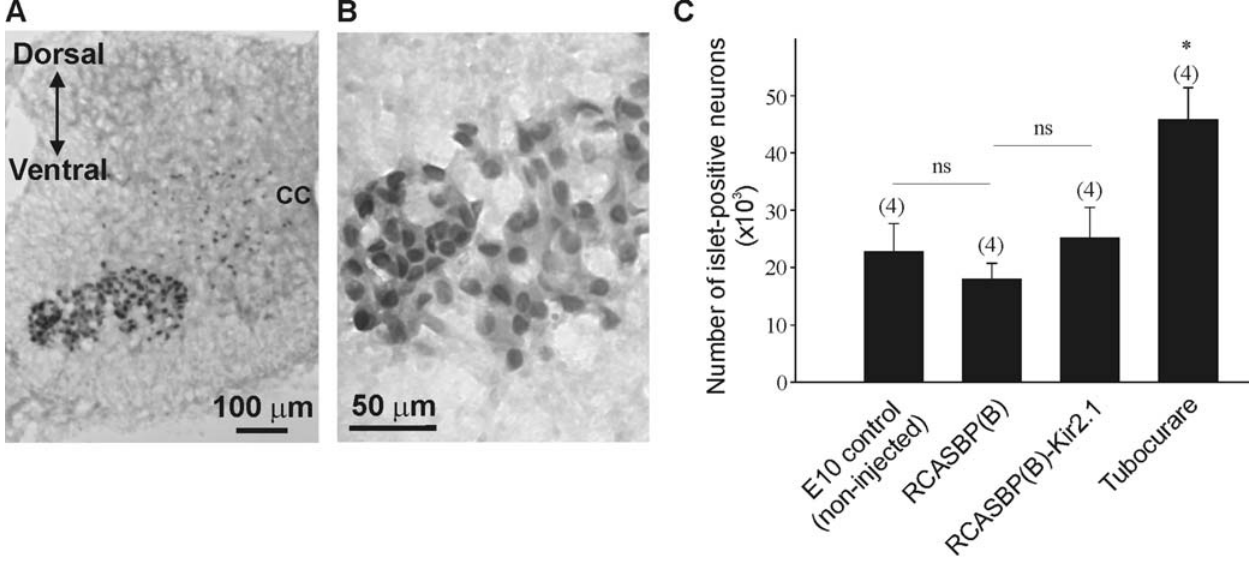
Figure 6. Effect of Kir2.1 expression on neuronal survival in non-injected, and RCASBP(B) and RCASBP(B)-Kir2.1 infected embryos. A) Islet staining in the lumbar spinal cord of a Kir2.1-infected embryo. B) Higher magnification image of the ventral spinal cord cross section represented in A.C) Inhibition of electrical activity in RCASBP(B)- Kir2.1 infected embryos does not alter motoneuron survival, whereas application of the neuromuscular blocker tubocurare caused a significant increase in the number of surviving neurons. The number of Islet -positive neurons on both sides of the lumbar spinal cord was counted using design-based stereology. Chicken embryos were infected with RCASBP(B)-Kir2.1 or RCASBP(B) open vector at E2 and motoneuron survival was assessed at E10 from six lumbar segments (L1–L6). embryos infected with RCASBP(B) or RCASBP(B)-Kir2.1. Under